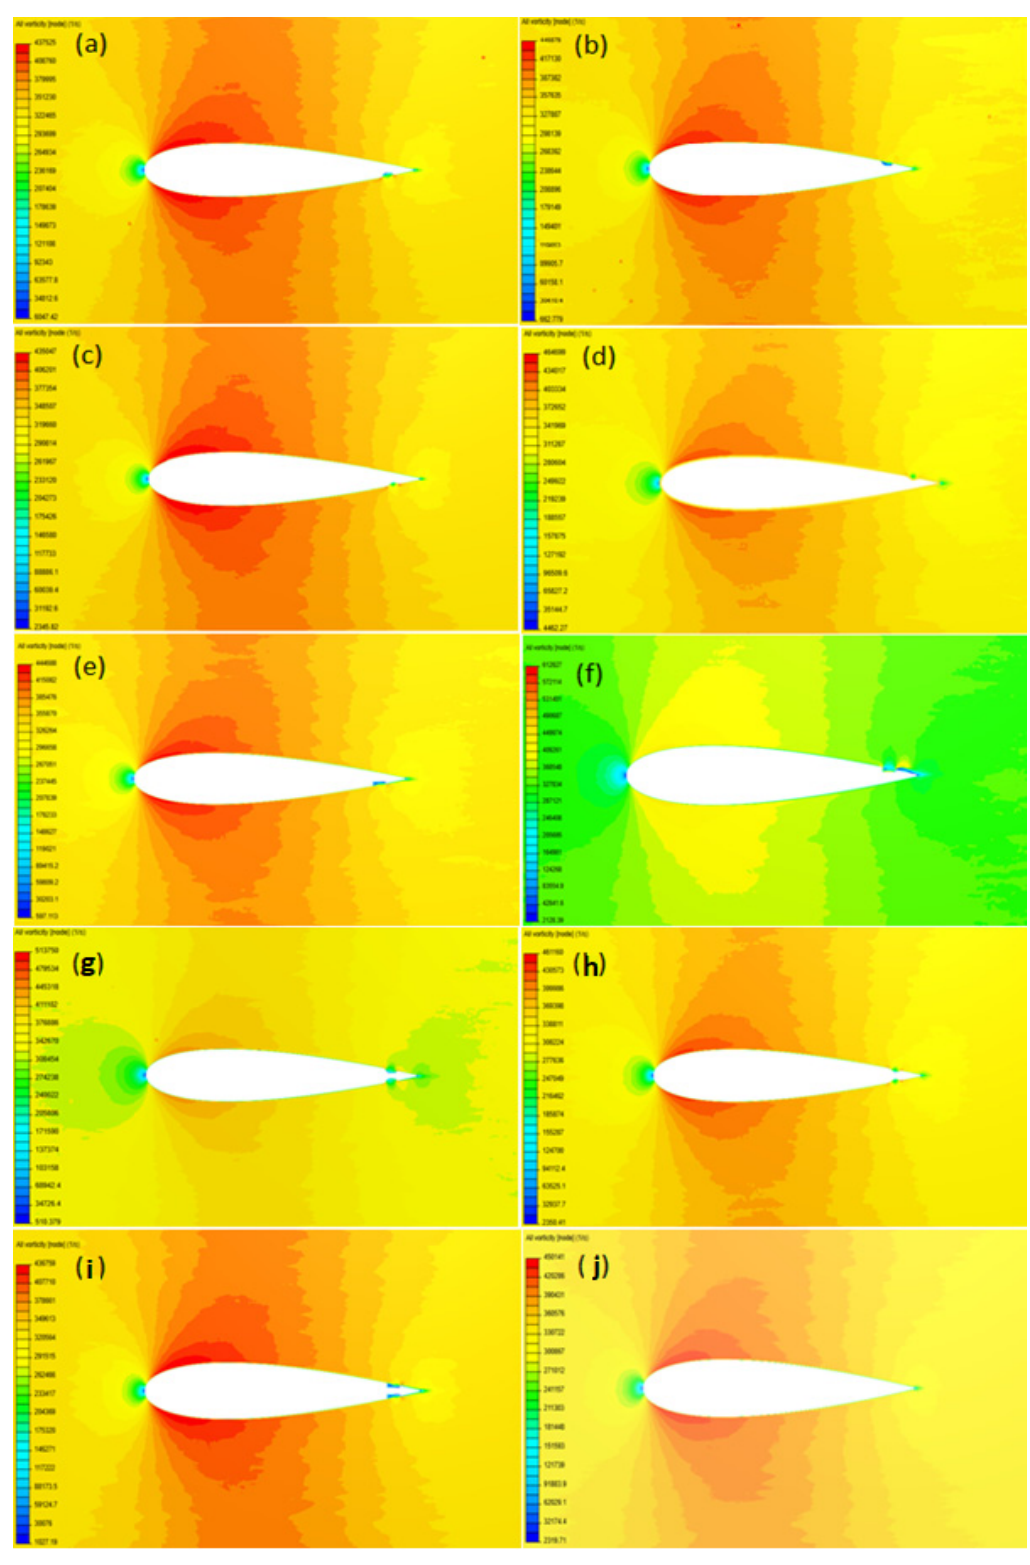
Figure 19. Vorticity profile on ( a ) round bottom dimple, ( b ) round top dimple, ( c ) triangle bottom dimple, ( d ) triangle top dimple, ( e ) square bottom dimple, ( f ) square top dimple, ( g ) round dimple both ends, ( h ) triangle dimple both ends, ( i ) square dimple both ends, and ( j ) no dimple aerofoil design.